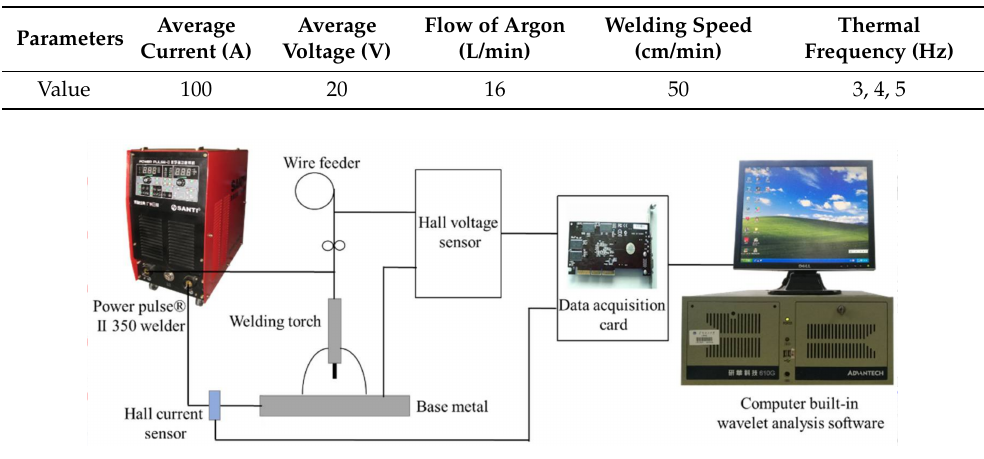
Figure 2. The experimental setup of DP-GMAW.